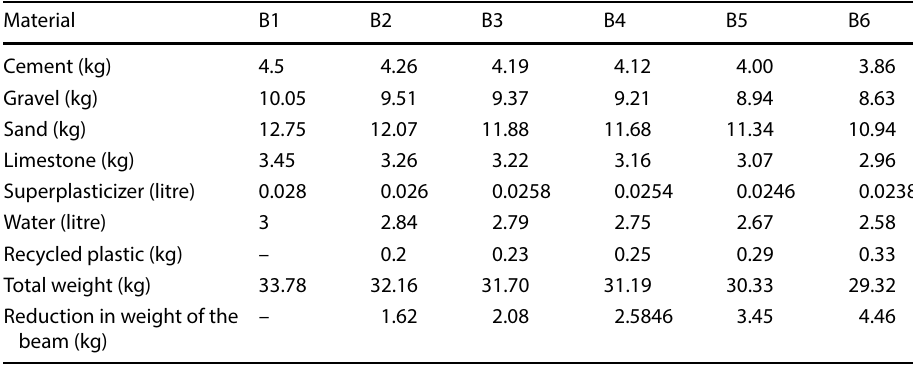
Table 9 Embodied Energy (EE) and carbon dioxide (CO